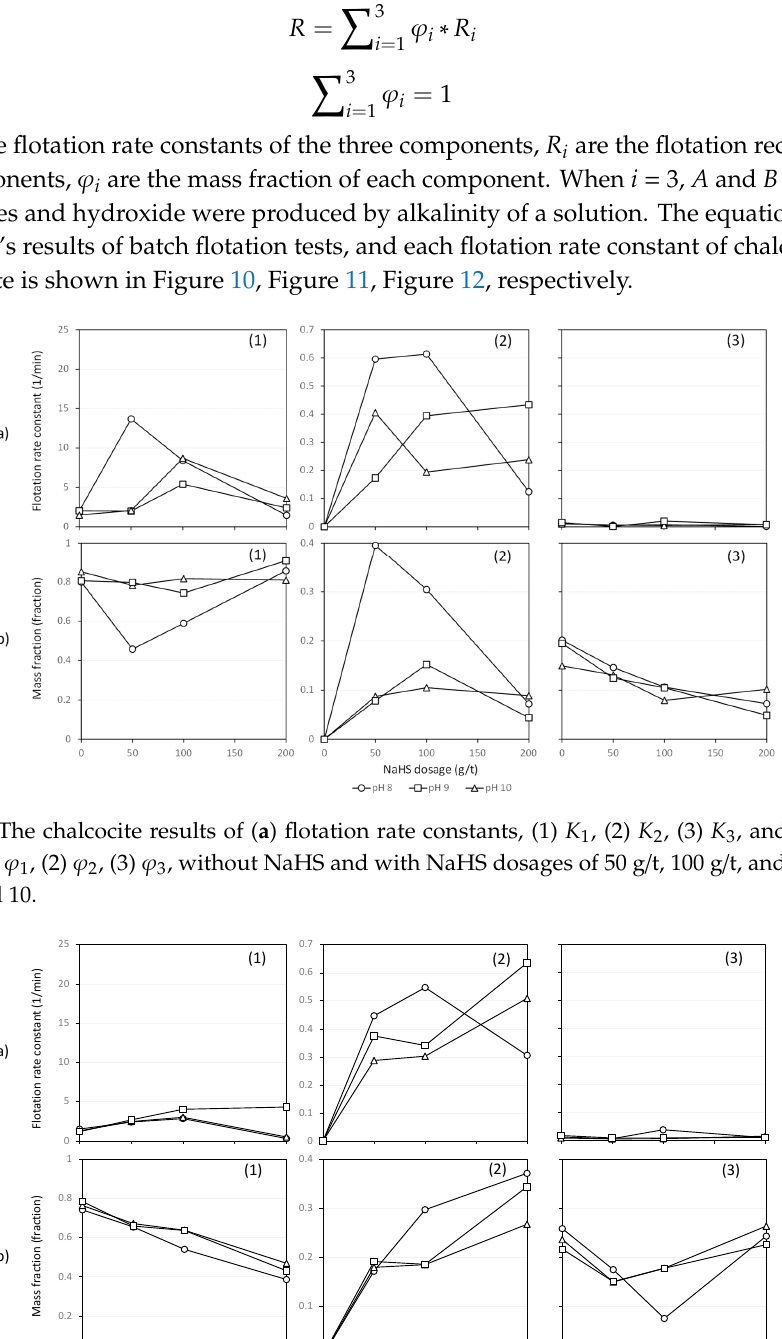
Figure 12. The chalcopyrite results of ( a ) flotation rate constants, (1) K 1 , (2) K 2 , (3) K 3 , and ( b ) mass fraction, (1) φ 1 , (2) φ 2 , (3) φ 3 , without NaHS and with NaHS dosages of 50 g/t, 100 g/t, and 200 g/t at pH 8, 9, and 10.